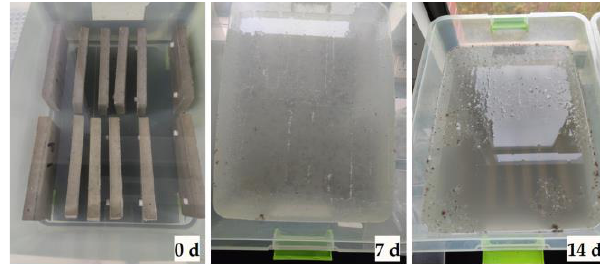
Figure 7. Water quality over time.